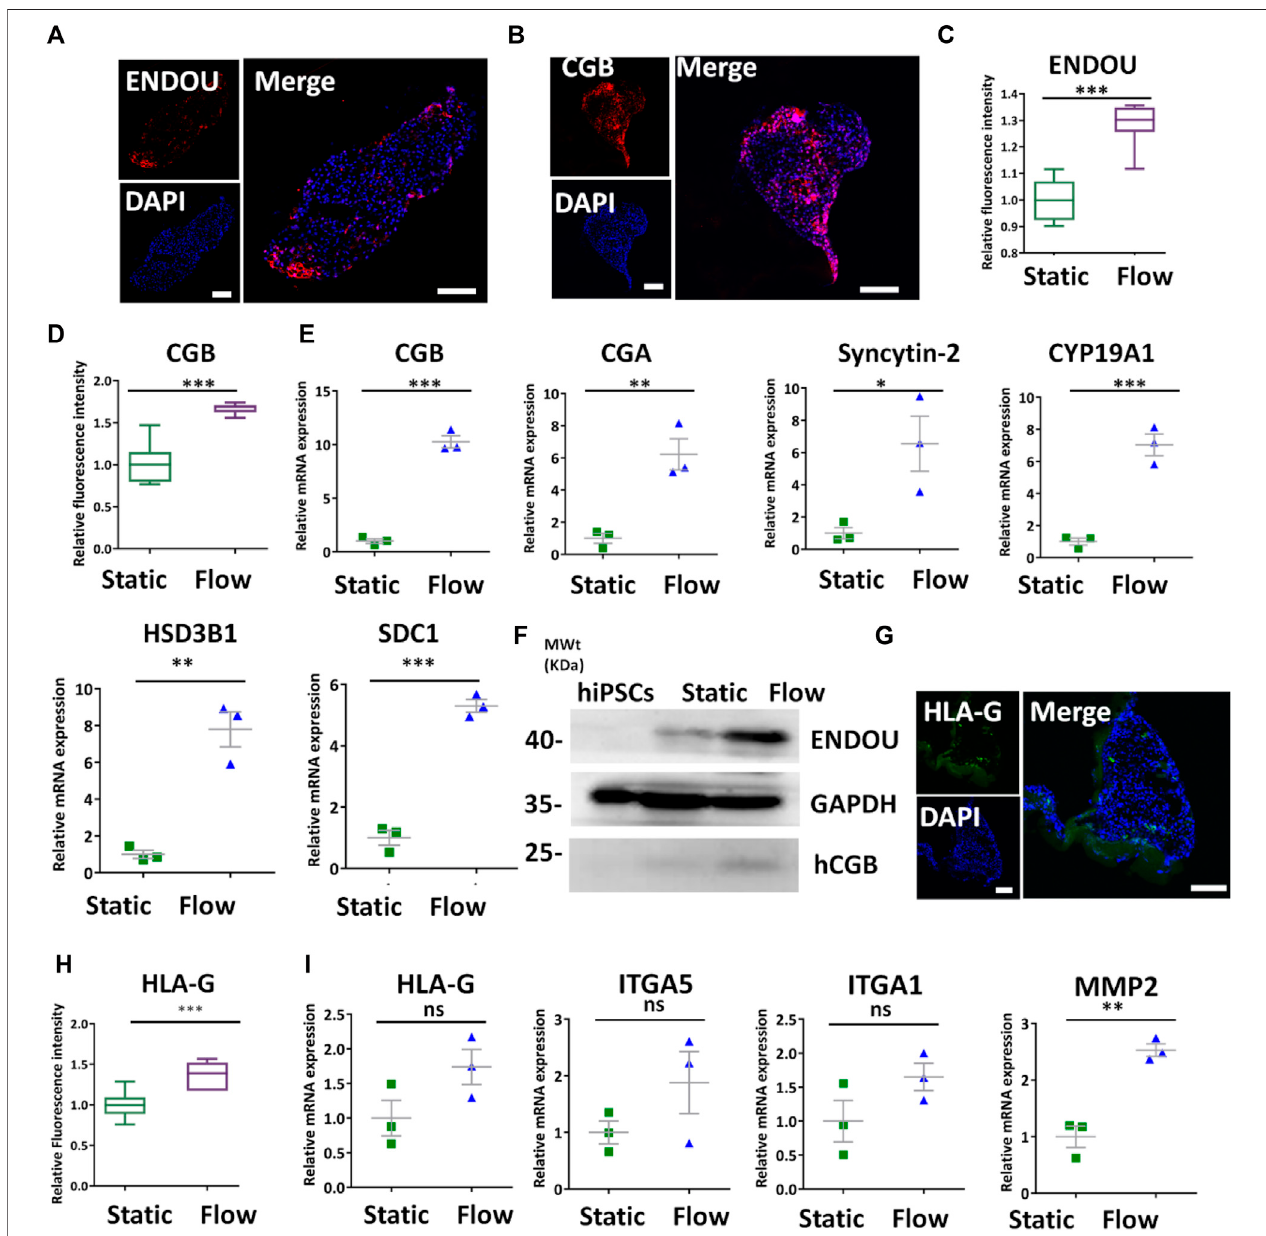
FIGURE 4 | Characterization of STBs and EVTs ’ differentiation in 3D tissues under dynamic conditions. (A,B) Representative immuno fl uorescent images showing theSTB-associatedmarkersENDOUand CGBunderdynamicconditionsattherateof1 ml/min.Scalebars,100 μ m. (C,D) ENDOU + and CGB + cellswerequanti fi edin 3D tissues under dynamic and static conditions. The data are indicated as mean ± SEM ( n > 3). (E) qRT-PCR analyses were performed to detect the STB-related markers (listed in fi gure) under static and dynamic conditions. (F) Western blot revealed more STB marker expressions under dynamic conditions compared with those found in hiPSCs and static conditions. (G) Immuno fl uorescent images indicated HLA-G expression under dynamic conditions. Scale bar = 100 μ m. (H) HLA-G + wasquanti fi edin3D cultures under differentconditions. Thedataare indicated asmean±SEM ( n > 3). (I) EVT-relatedmarkers(listed previously) weredetected byqRT- PCR. GAPDH was used as the reference gene. Data were mean ± SEM ( n = 3). The data were analyzed using Student ’ s t -test (* p < 0.05, ** p < 0.01, and *** p < 0.001). Scale bars, 100 μ m.